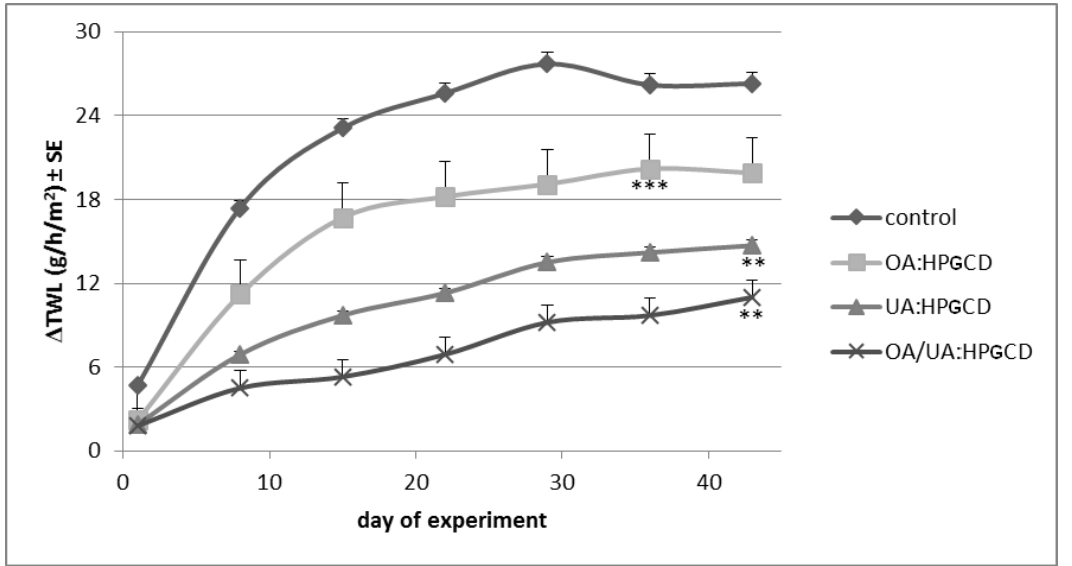
Figure 7. Transepidermal water loss.